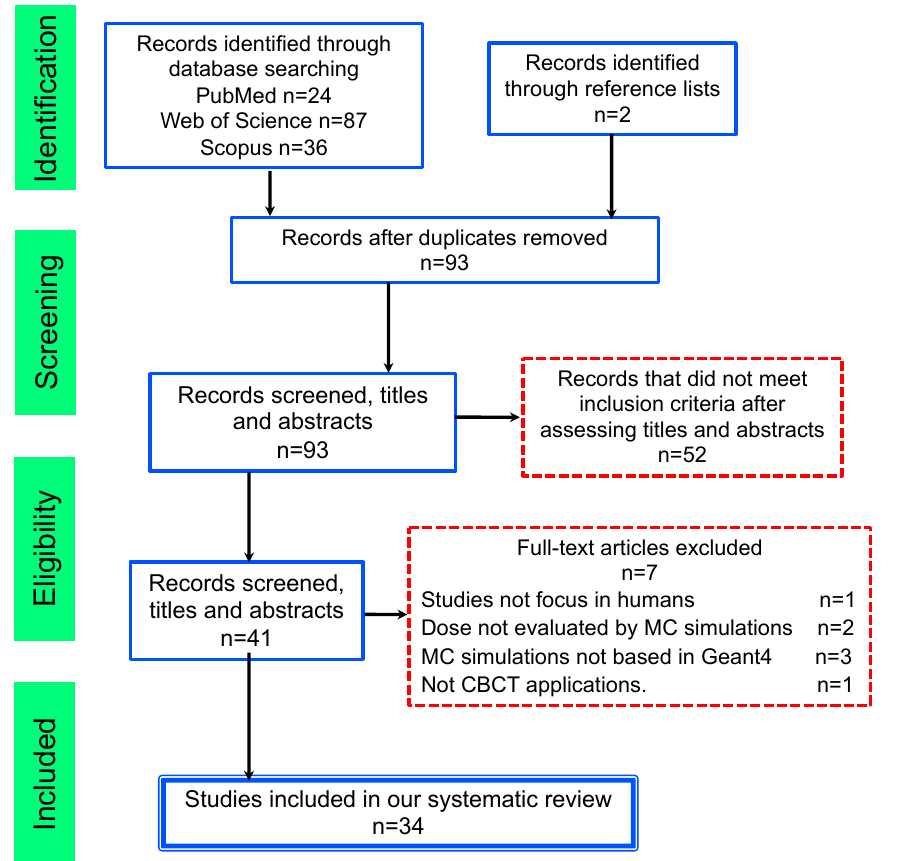
Figure 1. Flowchart consistent with preferred reporting items for systematic reviews (PRISMA) statement.